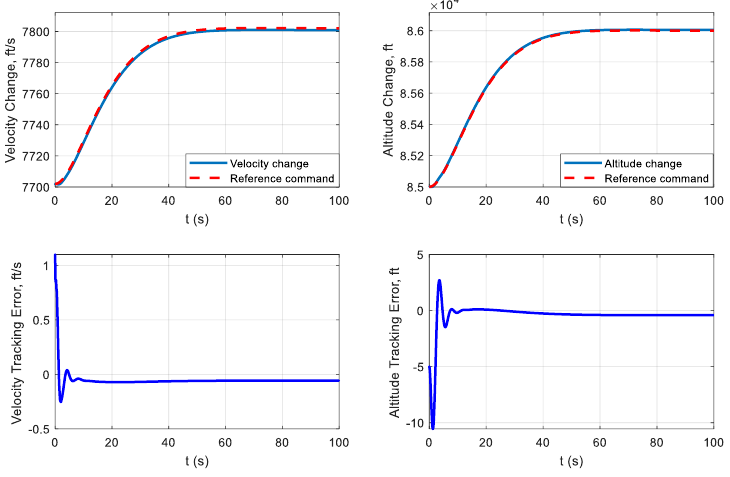
Figure 2. Tracking performance.